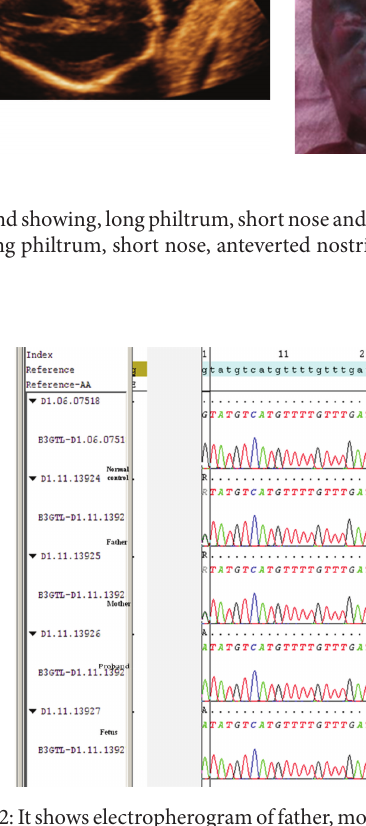
Figure2:Itshowselectropherogramoffather,mother,proband,and the fetus. Reference is the reference sequence of the B3GALTL gene. The region shown is the beginning of intron